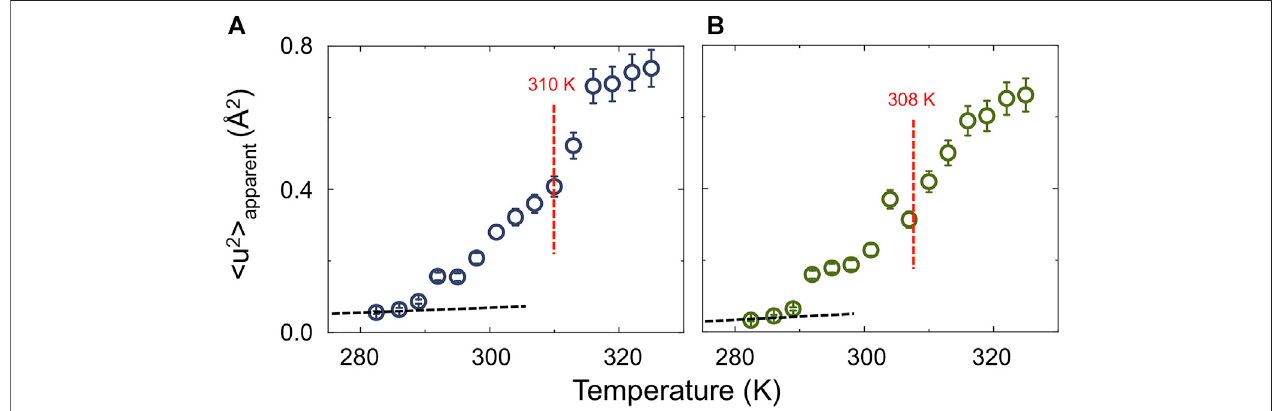
FIGURE3|(A) Temperaturedependenceoftheapparentmean-squaredisplacement < u 2 > apparent forfullyprotiatedDPPC:POPC:Cholmolarratio2:2:1 (A) andits partially deuterated analogue ( d 75 -DPPC: h -POPC: d 46 - Chol; (B) . In the plot isreported the linear fi t at low-T (black dashed line) having aslope ” d < u 2 > /dT = 0.23 ± 0.05 10 – 3 Å 2 K − 1 . The red dashed lines indicate the mid point as obtained by sigmoidal fi t, suggesting a cooperative transition form raft to homogenously dispersed